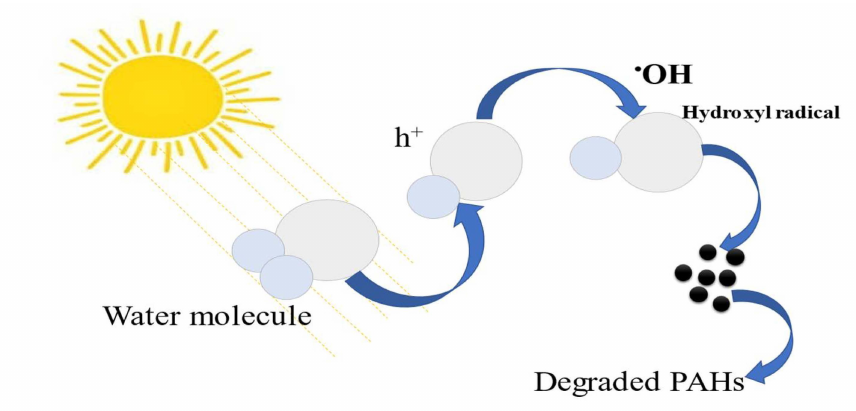
Figure 3. The mechanism of the photodegradation of